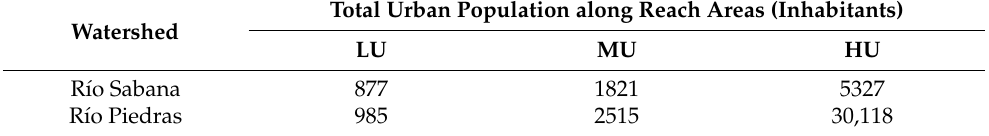
Table 1. Classification of the intensity of urban population in study sites reaches along the urban (R í o Piedras) and forested (R í o Sabana) watersheds. These sampling sites were classified under the following criteria: high urban (HU)—a total population between 2500 to 50,000; medium urban (MU)—a population between 2500 to 1000, and low urban (LU) less than 1000 inhabitants [19]. Total Urban Population along Reach Areas (Inhabitants) Watershed LU MU HU 877 R í o